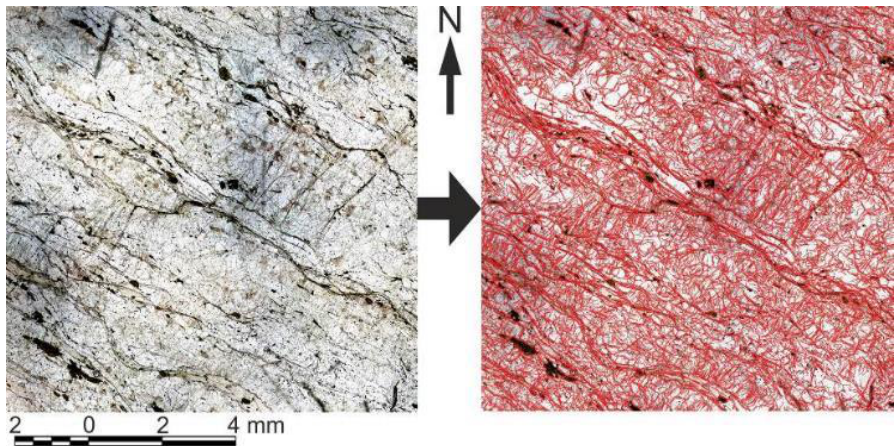
Figure 6. The result of detecting and marking microfractures in a part of the oriented thin section of the sample 58-1 using STMA.